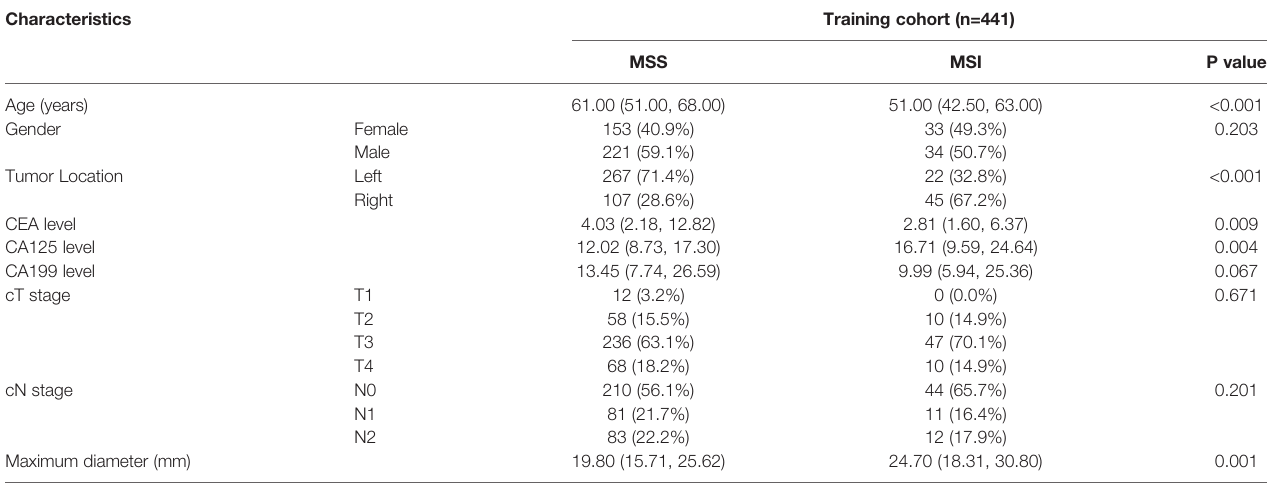
TABLE 1 | Characteristics of patients in the training cohort [median (Q1, Q3) or no. (%)]. Characteristics